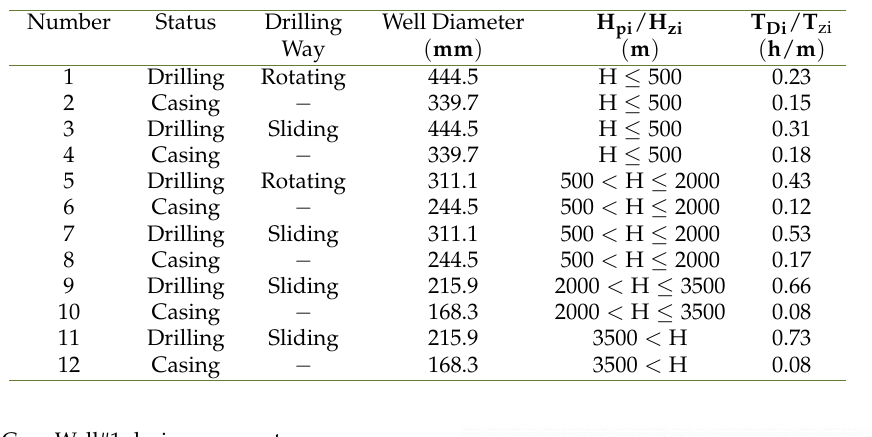
Table 2. Case Well#1 design parameters